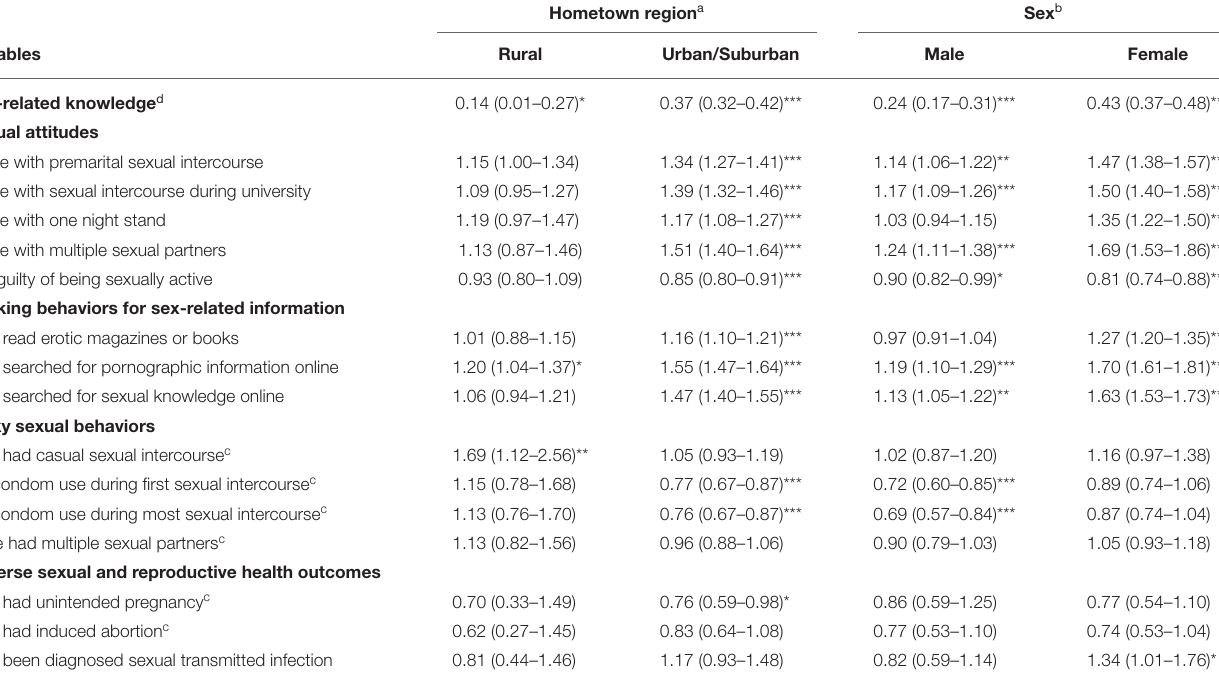
TABLE 3 | Associations between only-child status with sex-related knowledge, attitudes, behaviors and SRH outcomes stratified by region and